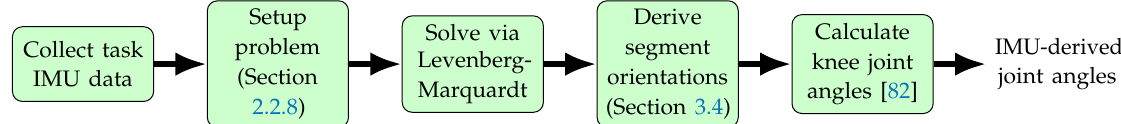
Figure 5. Conceptual process methodology to compute IMU-derived joint angles for the human motion profile task. Levenberg–Marquardt is used as an iterative solver to the proposed optimization